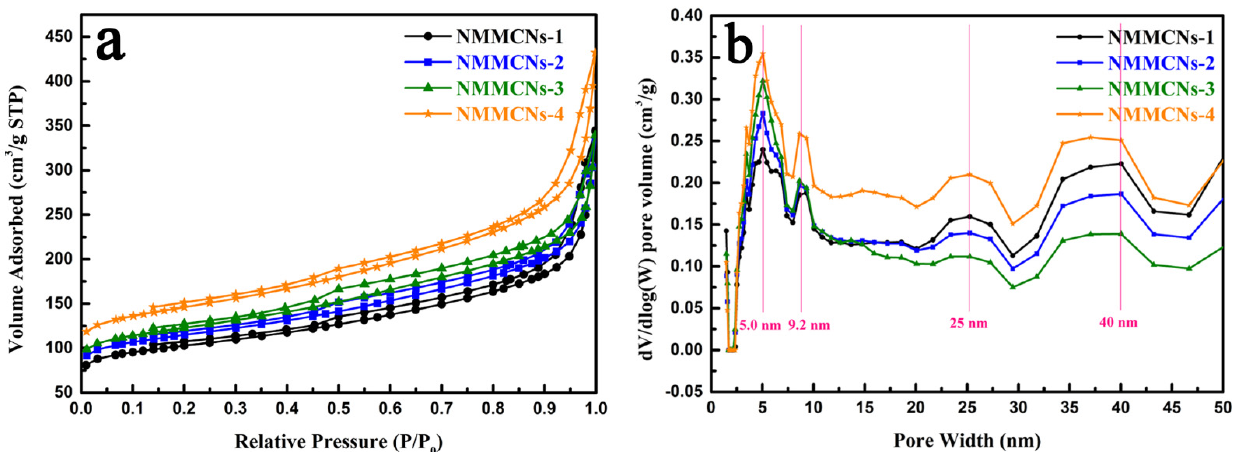
Figure 3. Nitrogen adsorption–desorption isotherms ( a ) and the corresponding PSD curves ( b ) of NMMCNs-1, NMMCNs-2, NMMCNs-3 and NMMCNs-4.